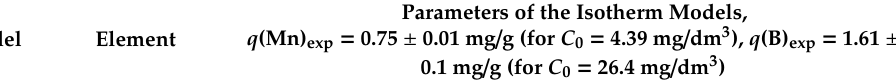
Table 2. Parameters of the Langmuir, Freundlich, and Dubinin–Radushkevich isotherms on hybrid chitosan-zirconium hydrogel beads at 25 ± 1 ◦